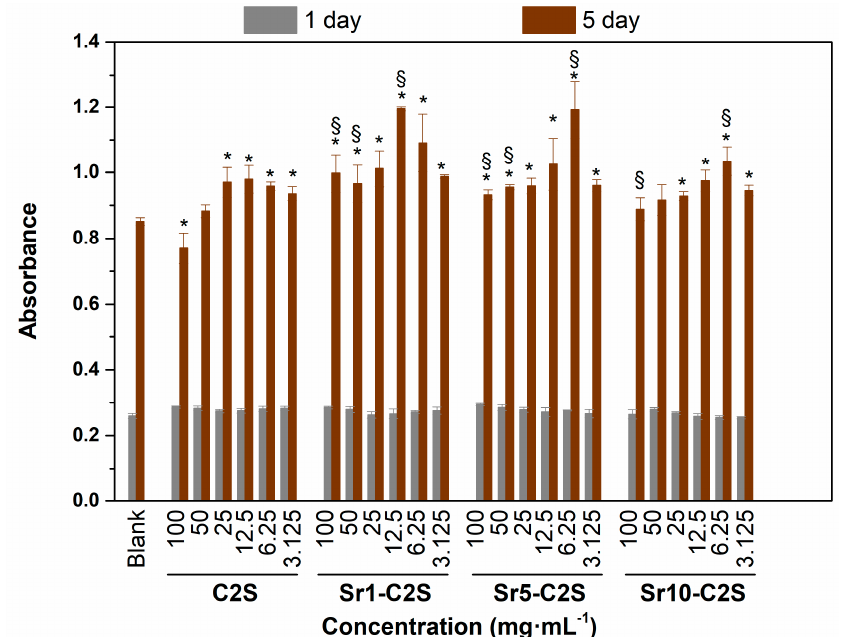
Figure 11. The proliferation of hBMSCs in the medium supplemented with C2S, Sr1-C2S, Sr5-C2S and Sr10-C2S after culturing for 1 and 5 days. The cells cultured in medium without C2S or Sr-C2S were treated as the control group. C2S and Sr-C2S groups show higher proliferation activity of hBMSCs than blank group. Furthermore, Sr-C2S groups show higher proliferation activity of hBMSCs than C2S group. * denotes significant difference exists between this group and the blank group. § denotes significant difference exists between this group and the C2S group at corresponding concentrations.